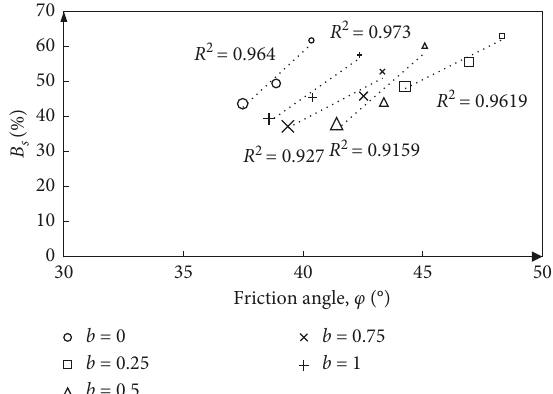
Figure 13: The relationship between particle breakage index B 0 ∼ 1 and internal friction angle (the size of the marker in the figure represents the magnitude of the mean